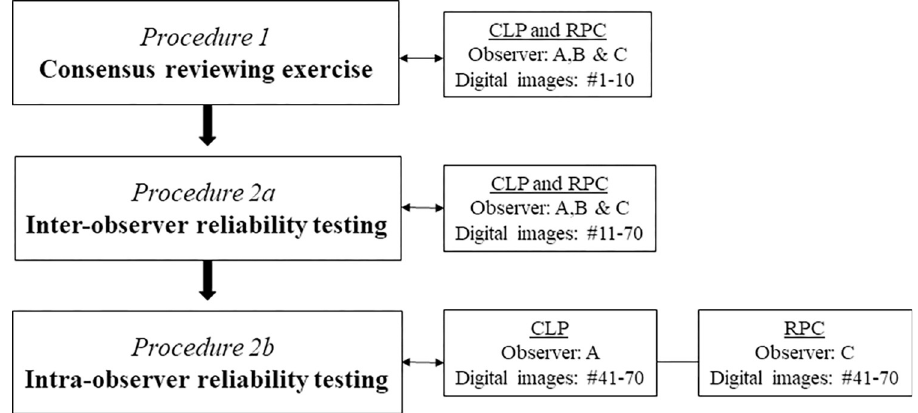
Fig 2. Flowchart displaying the different testing procedures in the FGS digital gridded imaging technique study in which 70 images of the cervical portio were reviewed for cervical lesion proportions (CLP) and rubbery papule counts (RPC),